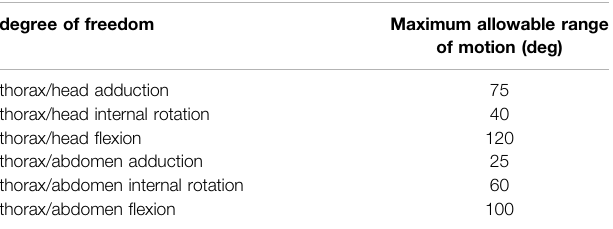
TABLE 2 | Maximum range of motion allowable for each degree of freedom of the leg joints. Values are presented per leg: front, middle, and rear. The same valueswereusedforleftandrightlegs.ThesevaluesweredeterminedinOpenSim by articulating each degree of freedom of the model until some structures of the joint segment touch. Non-allocated values (NA) correspond to blocked degrees of freedom.